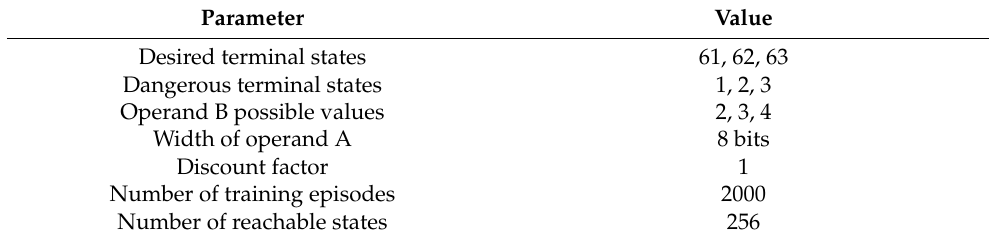
Table 8. Configuration parameters held constant throughout the training process in the “optimality of state grouping” section.